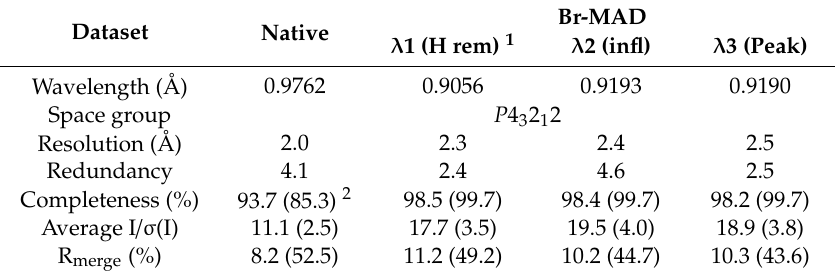
Table 1. Data collection statistics for Br-MAD phasing.